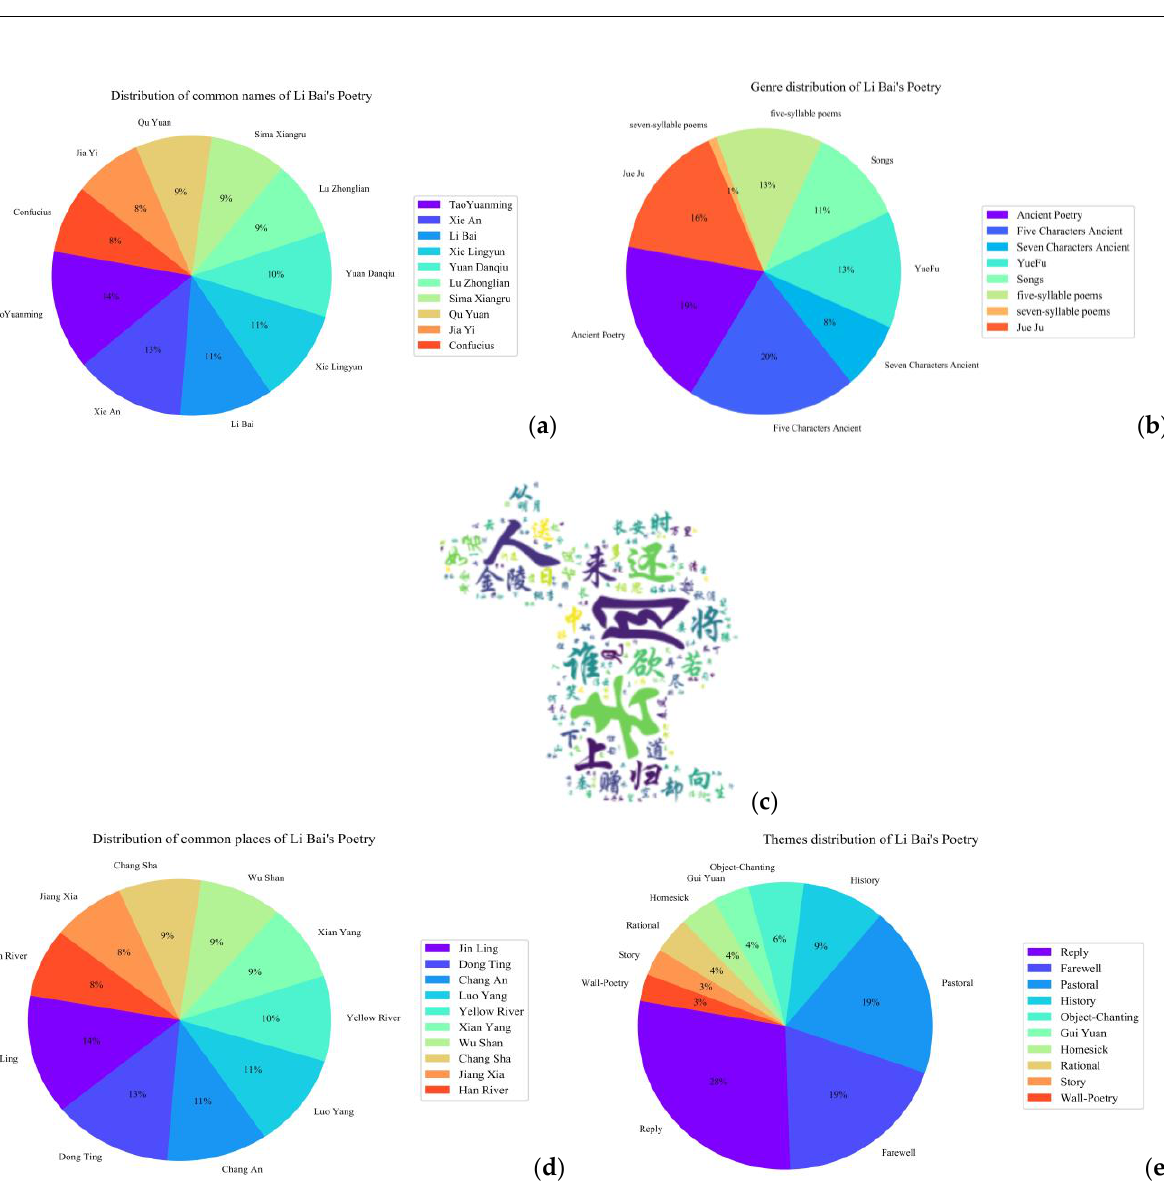
Figure 8. Li Bai profiling for stylistic text ( a ): names; ( b ): genres; ( c ): words (Use different colors to distinguish); ( d ): places; ( e ): themes.